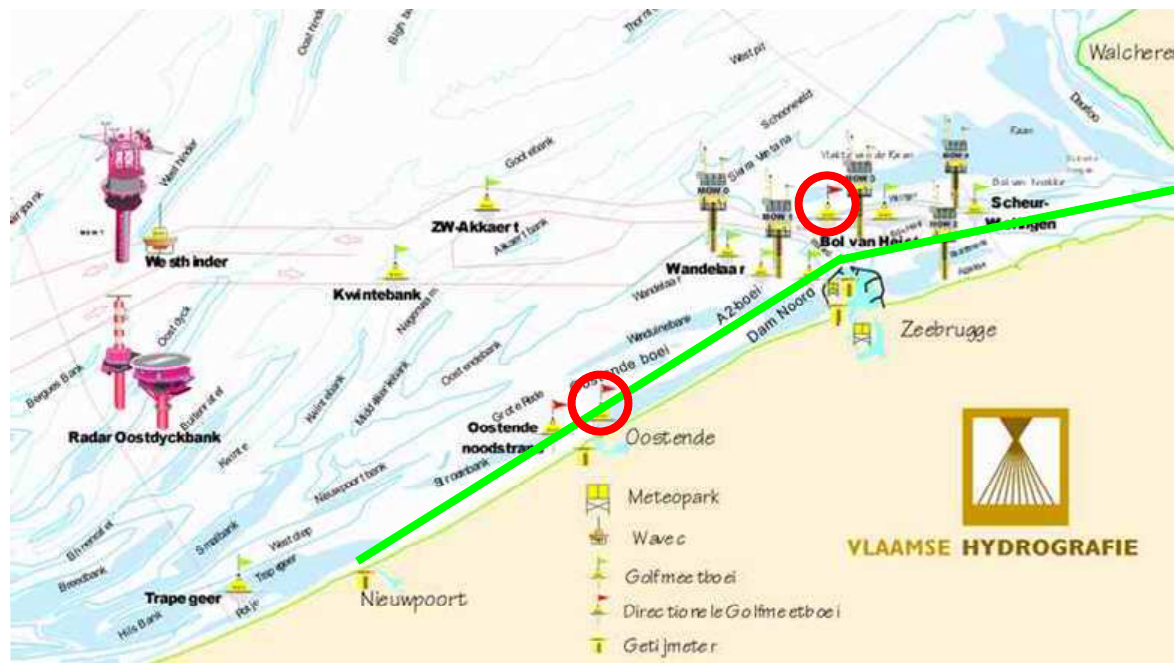
Figure 5. Measuring Network Flemish Banks (Meetnet Vlaamse Banken). Trajectories (green lines) for estuary traffic Western Scheldt – Zeebrugge – Nieuwpoort and locations of directional wave buoys (red circles) Bol van Heist and Oostende. Source: adapted from Vlaamse Hydrografie.